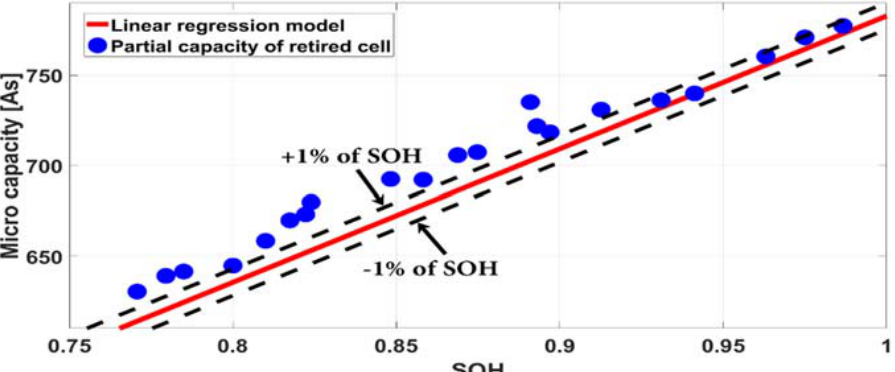
Figure 27. Comparison between the linear regression model based on the partial capacity of cell no. 1 and a real SOH based on the partial capacity of the retired cell. Table 5. Numerical results for comparison between the linear regression model based on the IC curve peak point of cell no.1 and a real SOH for the IC curve peak point of a retired cell (SOH error = Real SOH − Model SOH).